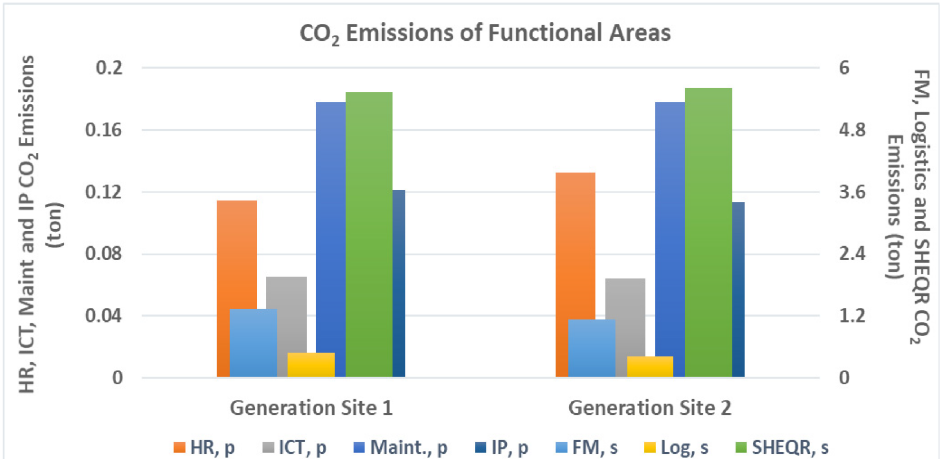
Figure 6. CO emissions of the various functional areas at each generation site 2